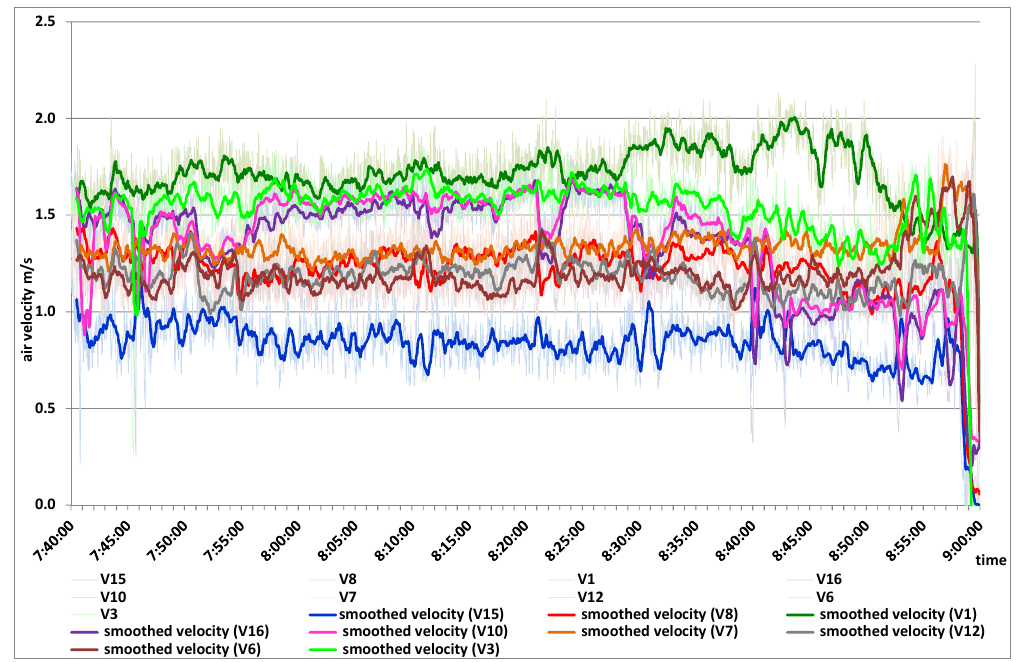
Figure 7. Smoothed air velocity curves from the multi-point system in longwall Cw-4. Figure 8 shows the recorded methane concentrations that were obtained using the multi-point system in the cross-section of longwall Cw-4. These were measured locally by methane-anemometers that were near the powered roof support section 7 in relation to equipment operation, measured from 7:40 to 9:00.